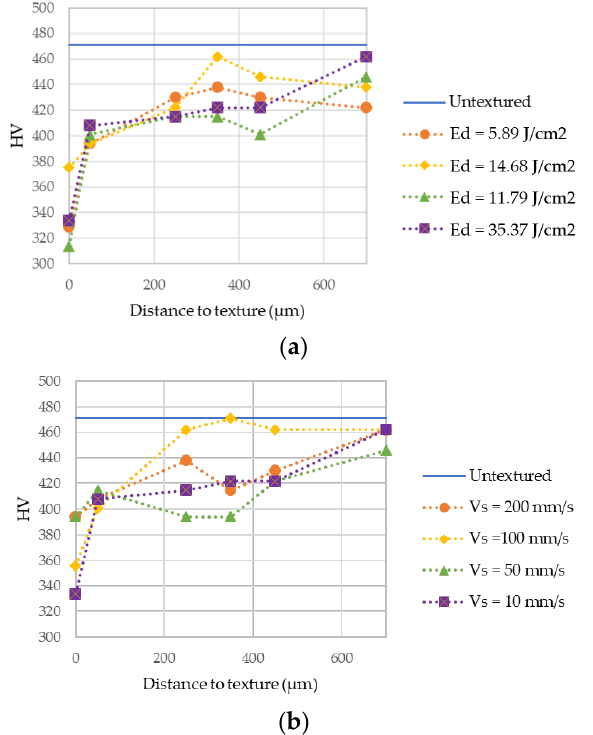
Figure 6. Micro-hardness: ( a ) At different Ed at fixed Vs = 10 mm/s; ( b ) At different Vs at fixed Ed = 35.37 J/cm 2 .